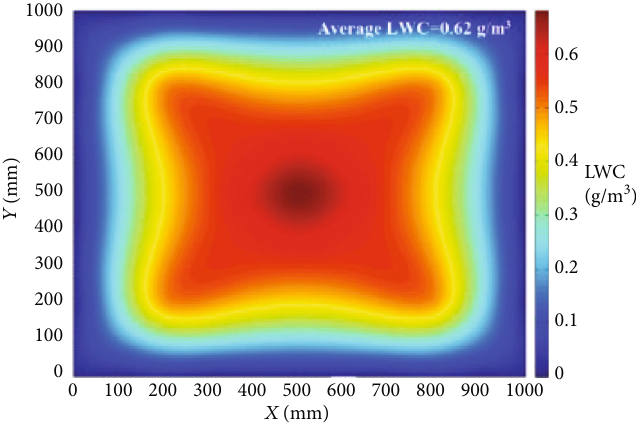
Figure 9: Cloud picture of the LWC at the cross-section in the test section.